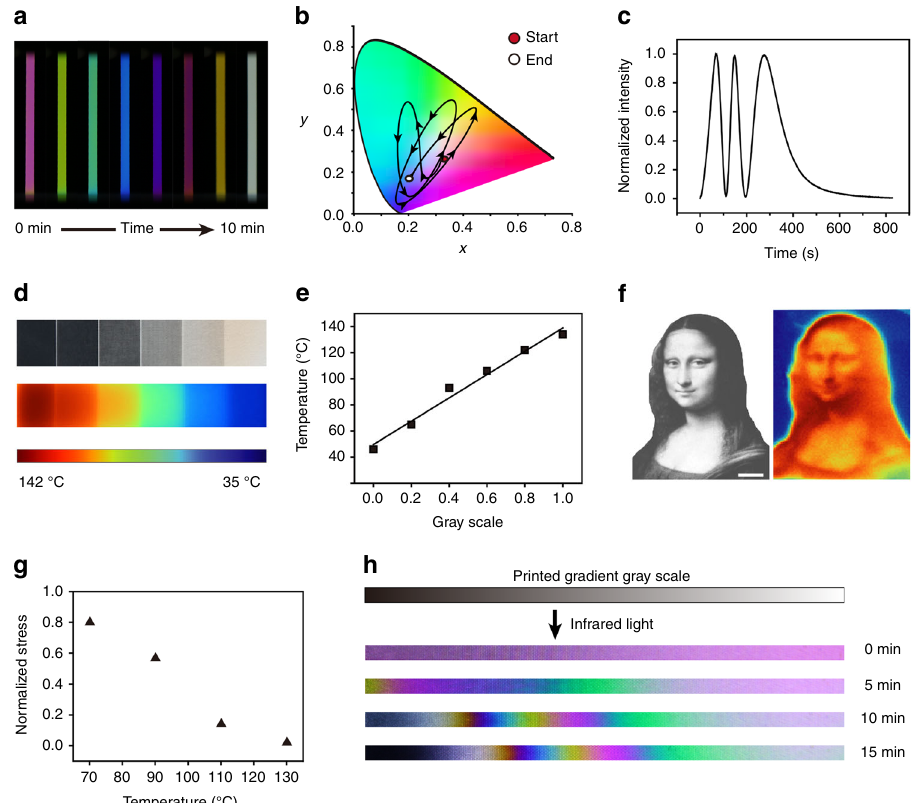
Fig. 3 Spatiotemporal control of partial plasticity by digital gray scale photothermal effect. a Time evolution of color during stress relaxation at 100 °C (strain: 70%, sample length: 4 cm). b Color change presented at a standard CIE-1931 color space (100 °C, strain: 150%). c Cyclic variation of light intensity (450 nm) with time corresponding to b . d Laser printed gray scale pattern (each square is 1 cm × 1 cm, gray scale of 1, 0.8, 0.6, 0.4, 0.2, and 0), and the corresponding infrared thermal image (the third colored line on the bottom represents the temperature scale). e Linear correlation between photothermal heating and the gray scale. f Gray scale photo of Mona Lisa and its infrared thermal image (the scale bar is 1 cm). g Normalized residual stress after photothermal heating for 1 min at different temperatures. h Infrared light-induced time evolution of color under polarized light in a pre-stretched fi lm (strain: 70%) printed with a gradient gray scale pattern. Ink is kept on the sample due to the continuous nature of this